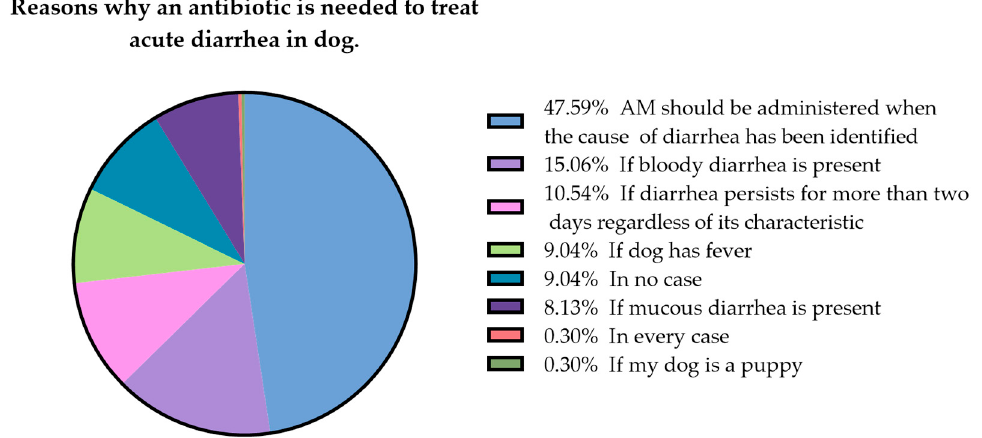
Figure 3. Reasons why, according to respondents, an antibiotic is needed to treat acute diarrhea in dogs. A value in the fi gure (“If my dog was senior”) was not plo tt ed because it was zero. AM: antimicrobials.